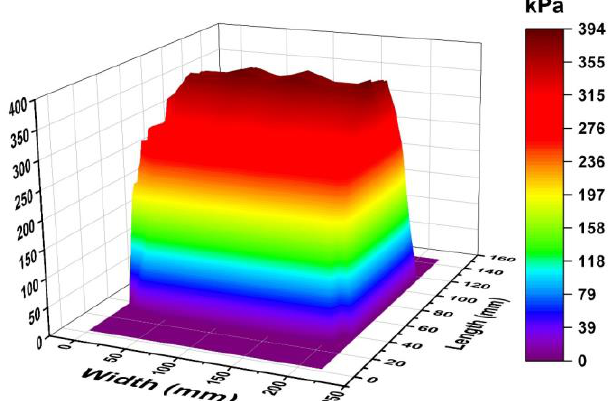
Figure 12. Vertical stress distribution in tire contact surface.